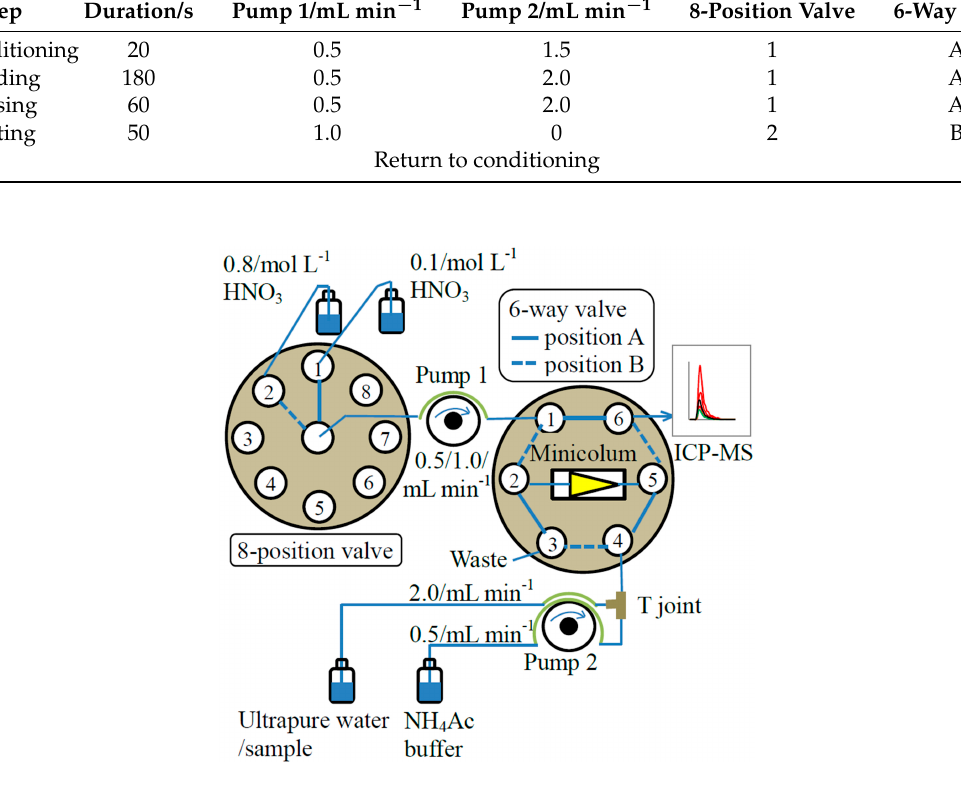
Figure 6. Schematic of the FI system and the FI-ICP-MS procedure.